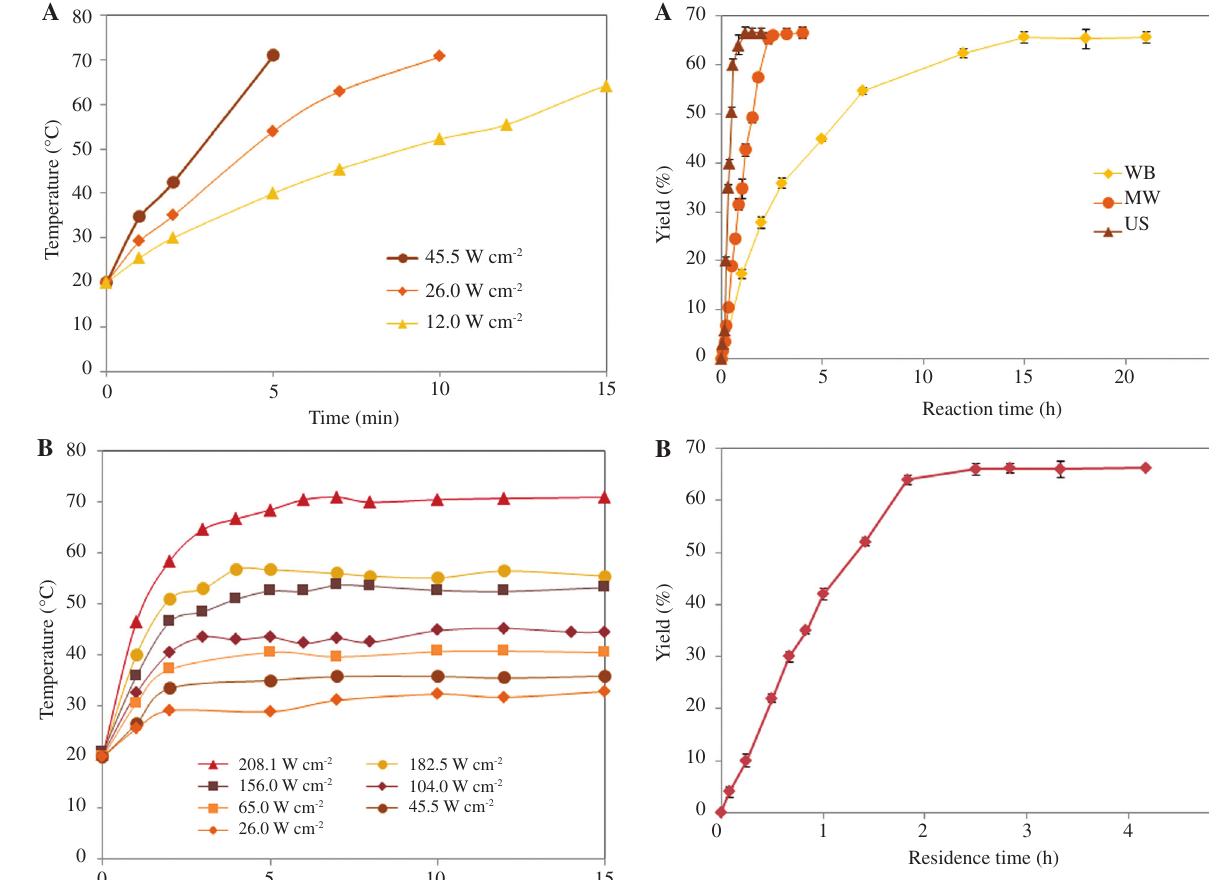
mmim][Br]: (A) Time courses of batch Figure 3 Synthesis of [C 7 processes using different heating systems: WB, thermostated water bath; MW, microwave irradiation; US, ultrasonication. (B) Product yield at the exit of the microchannel at total flow rates ranging from 2.2 to 220 μ l min -1 . Initial or inlet conditions: